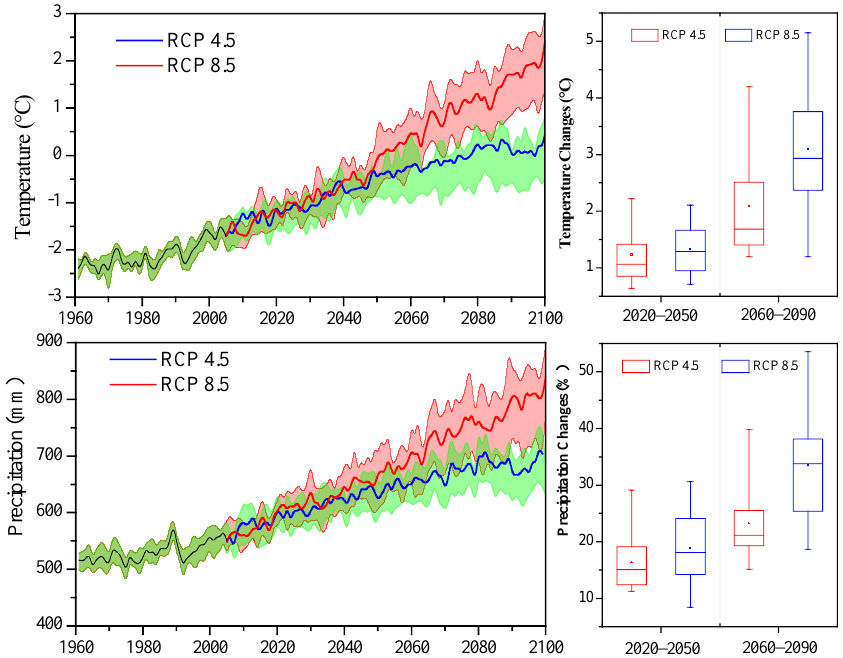
Figure 4. Annual temperature and precipitation variation derived from the ensemble of General Circulation Models (GCM) scenarios in the upper watershed of the Heihe River. The shadows and solid lines of the left panel represent the 90% predictive uncertainty and average value, respectively. In the box plot (right panel), the dot represents the average value and the upper and lower hinges represent the 75th and 25th percentiles, respectively. The whiskers show the other data points, except for the outliers. The line within the box shows the median.